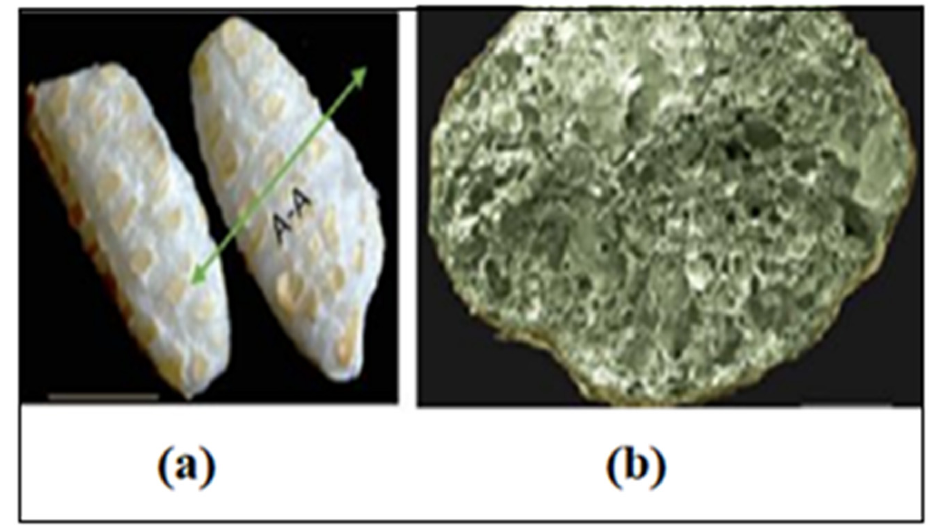
Figure 2. ( a ) SEM photograph of two puffed rice grains: Bar, 5 mm. ( b ) SEM cross section of a puffed rice grain showing air cells and a compact grain surface [23].